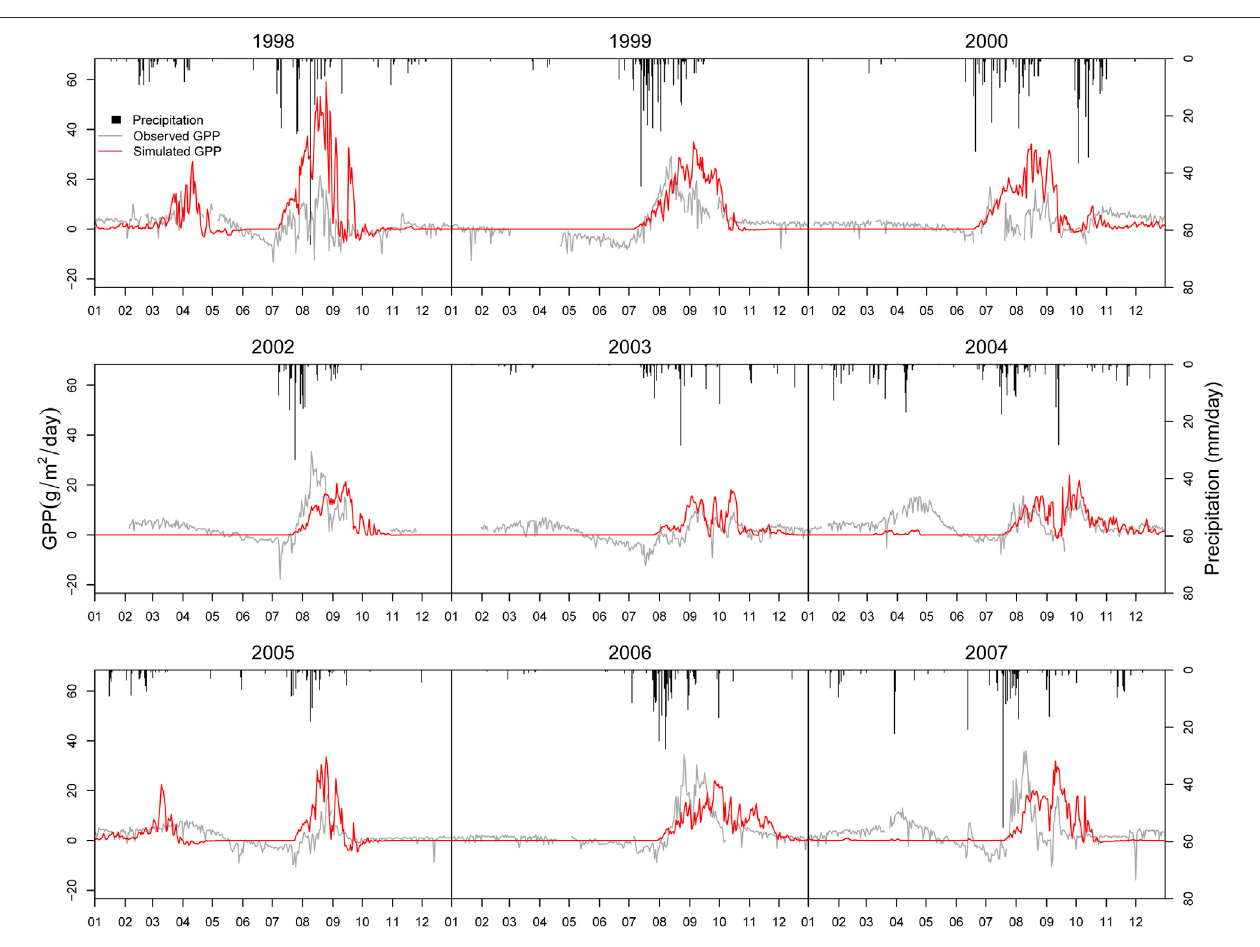
FIGURE 9 | Comparison of simulated daily GPP and NEE-partitioned GPP.